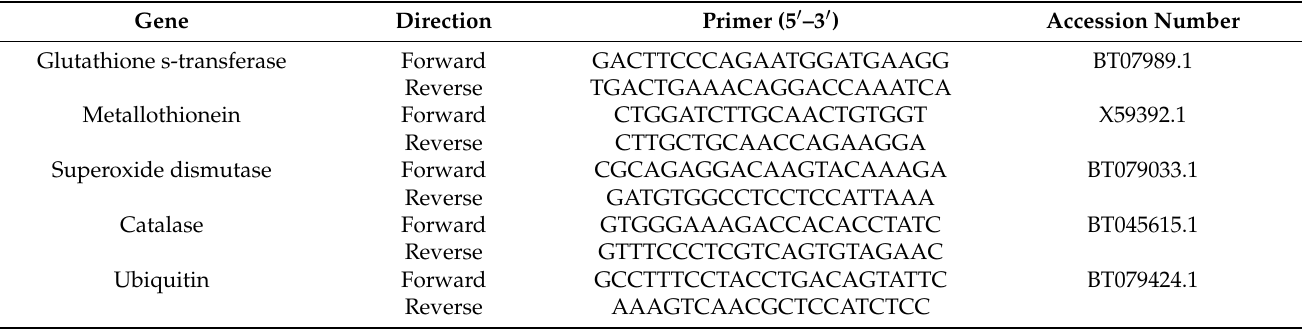
Table 1. Genes and primers used in qPCR analysis of livers in northern